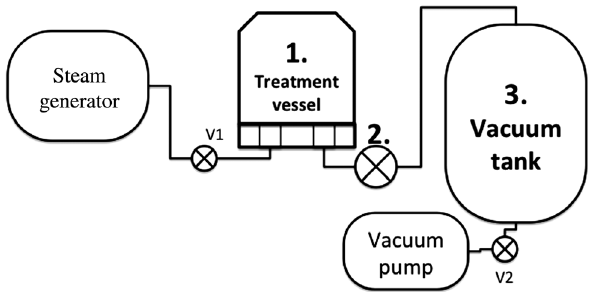
Figure 1 Schematic diagram of the industrial scale instant controlled pressure drop (DIC) unit (From ABCAR-DIC Process, La Rochelle, France): (1) high-temperature/high-pressure DIC treatment vessel; (2) instant-opening large-section valve; (3) large-volume vacuum tank; V1 and V2, conventional